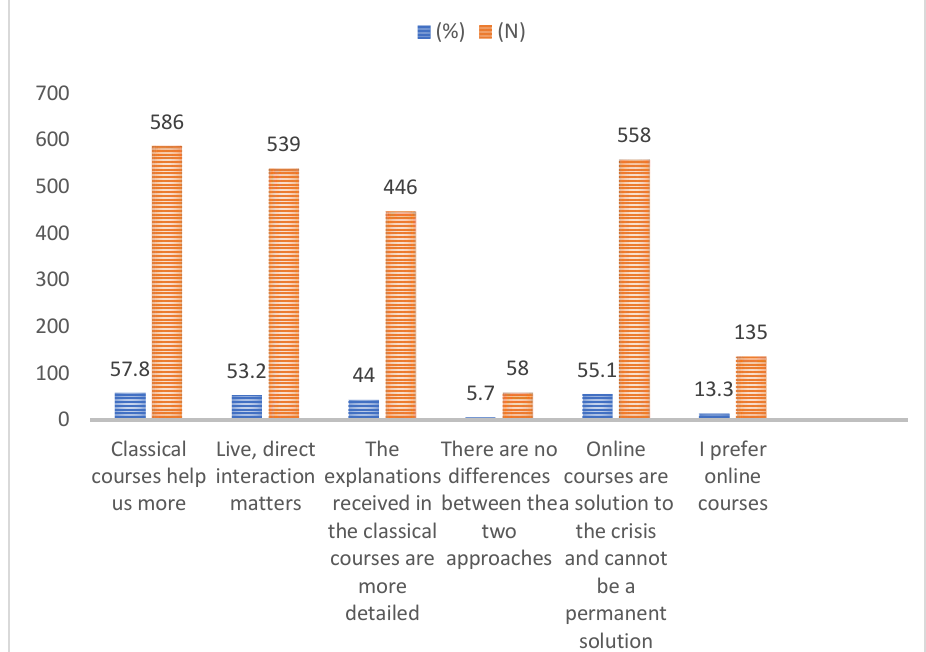
Figure 1. Opinions on the format of the courses.